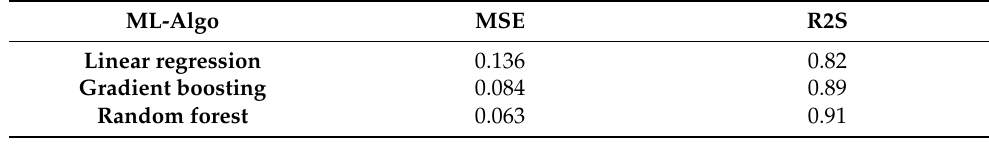
Table 5. Estimation results.